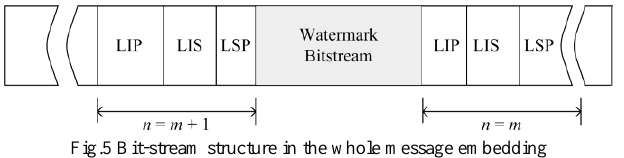
Fig.5 Bit-stream structure in the whole message embedding